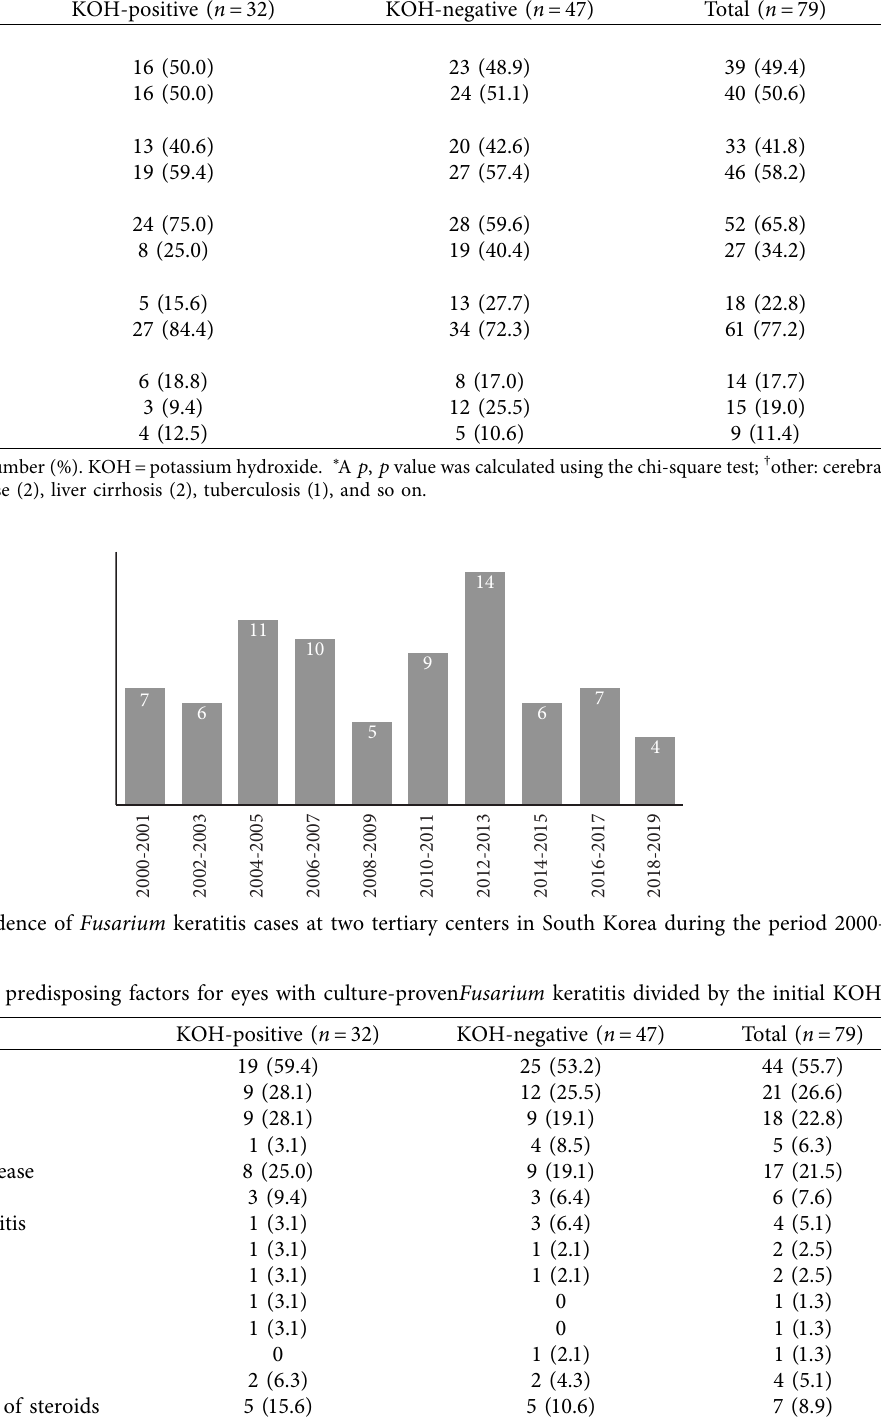
Table 1: Epidemiology for eyes with culture-proven Fusarium keratitis divided by the initial KOH smear. Characteristics